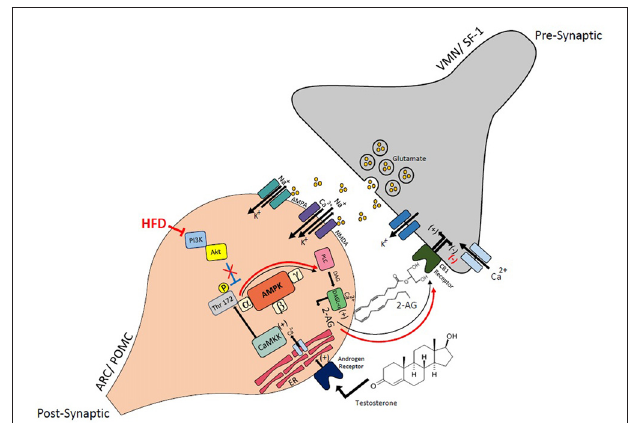
FIGURE 13 | Schematic illustrating the connectivity and EC signaling occurring at VMN SF-1/ARC POMC synapses in males, and how that signaling is rapidly modulated by androgens and influenced by diet. The magnified view of the VMN SF-1/ARC POMC synapse illustrates how testosterone activates a putative membrane androgen receptor to increase intracellular calcium. This increase in intracellular calcium activates calmodulin-dependent protein kinase kinase (CaMKK), which then phosphorylates threonine 172 on the α subunit of the AMPK complex to activate the enzyme. This activation leads to an increased production of 2-arachidonylglycerol (2-AG) through diacylglycerol lipase (DAGL) α , and the 2-AG released can retrogradely activate presynaptic CB1 receptors. This inhibits calcium entry, which decreases glutamatergic input. The resultant relief from the anorexigenic signal leads to hyperphagia. AMPK activity is inhibited by PI3K/Akt signaling, and this inhibition is reduced with HFD-induced obesity/insulin resistance. This further elevates AMPK activity and subsequently EC tone at VMN SF-1/ARC POMC synapses.